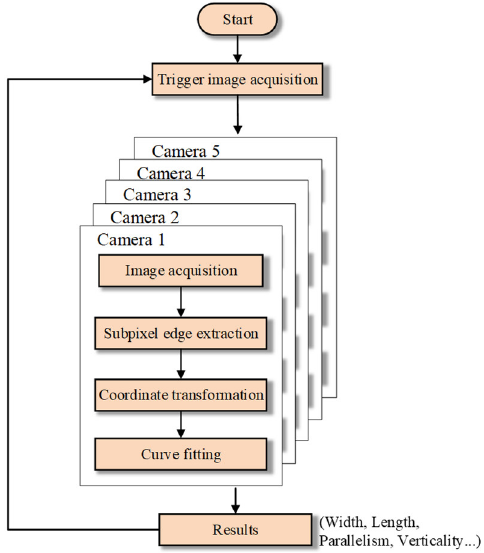
Figure 16. Algorithm flow of dimension measurement.